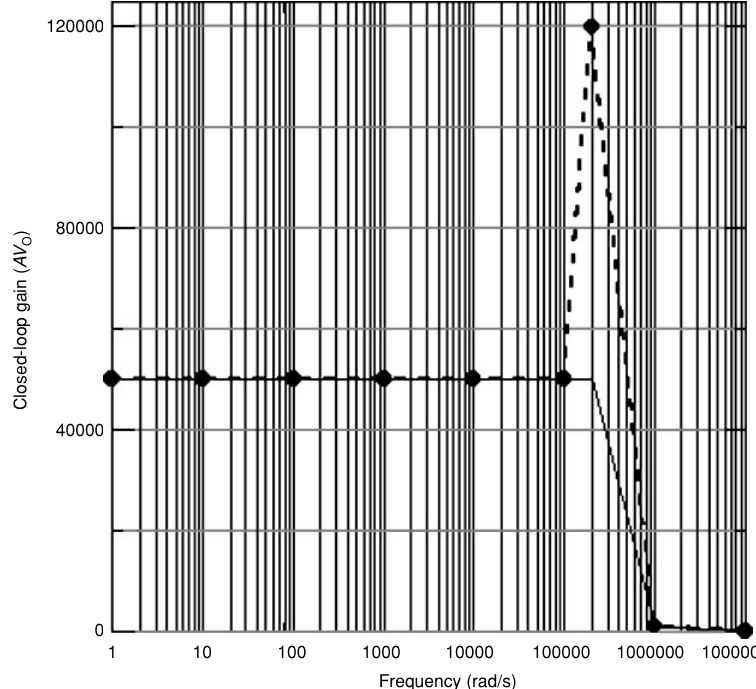
Figure 4 Experimental results of the model.